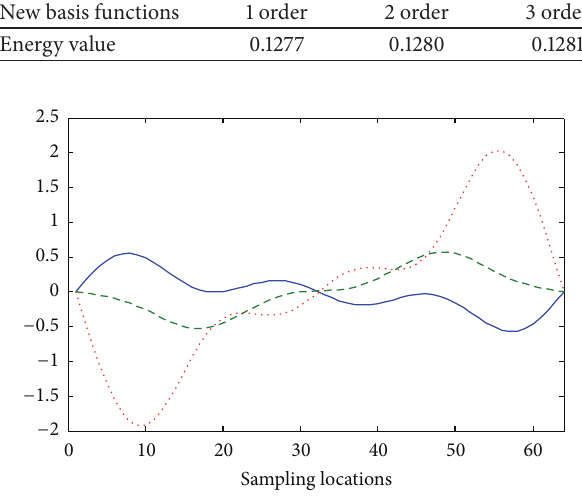
Figure 2: The first 3 optimal combined EEFs.